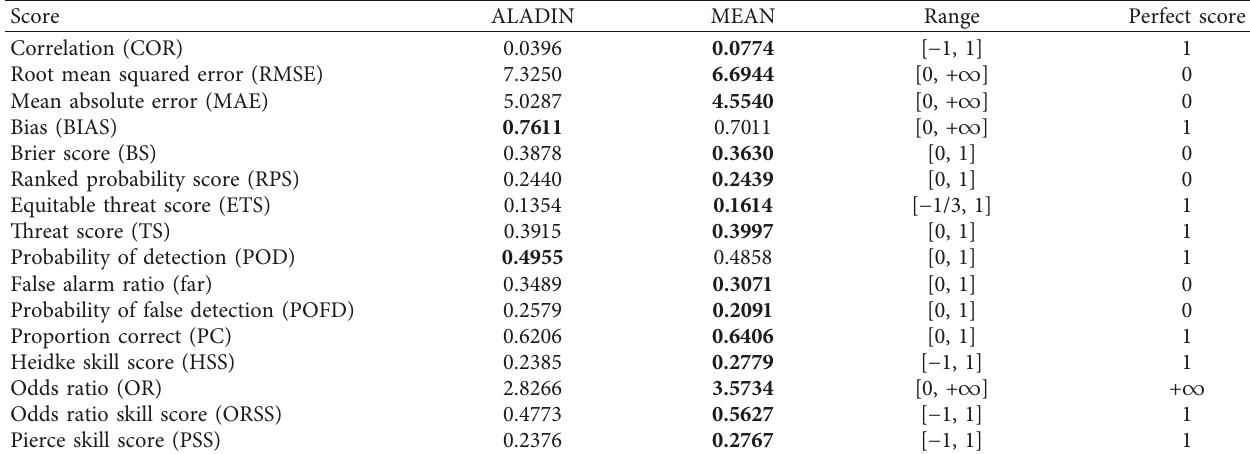
Table 1: Comparison of ALADIN and MEAN verification scores for all data together without dependence on lead time or threshold. Bold values indicate better